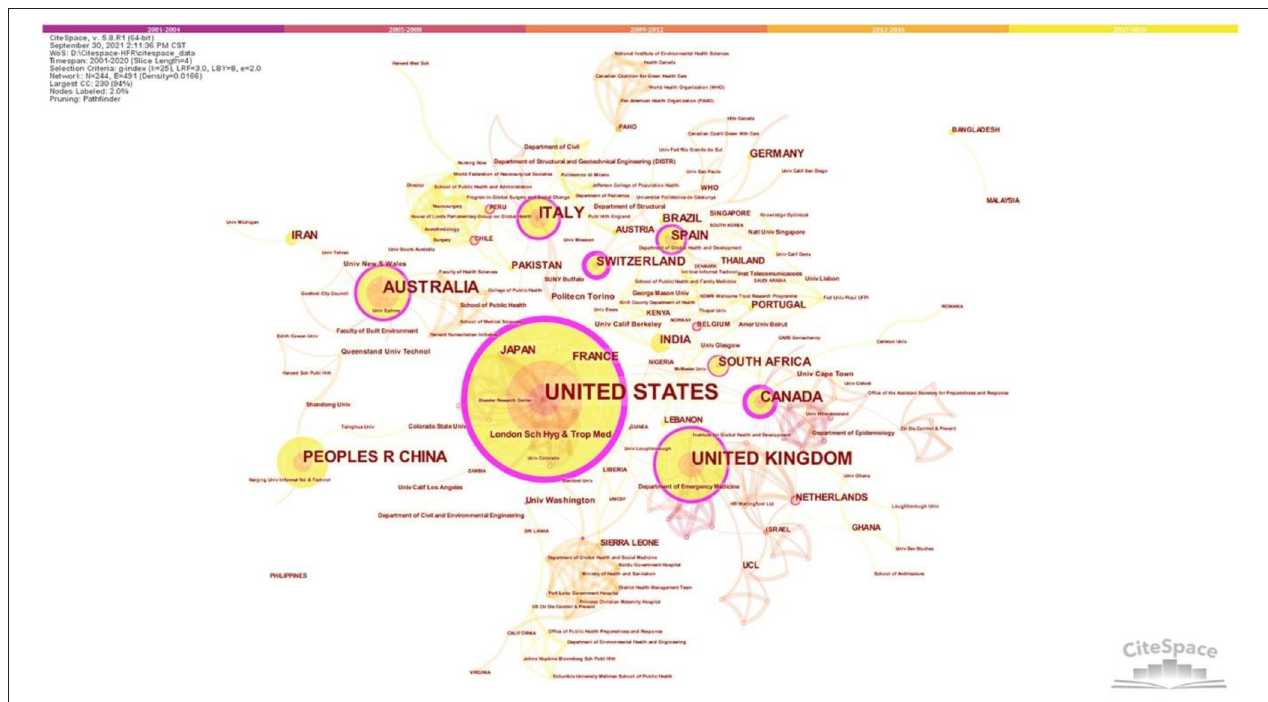
FIGURE 3 | Countries and institutions co-occurrence network.